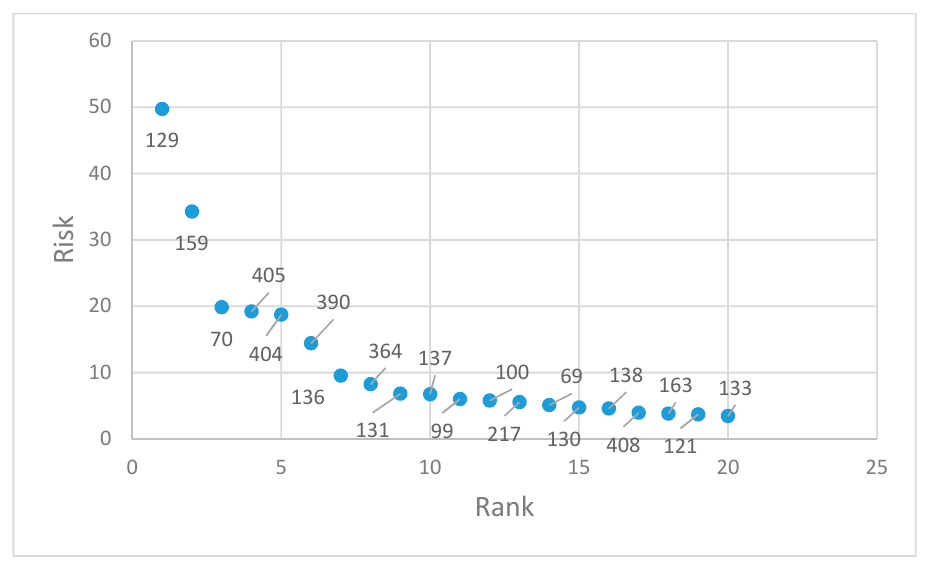
Figure 9. Priority ranking of the pipes with highest calculated risk values. Table 3. Ranking list of the pipes with highest risk values and the corresponding failure event number